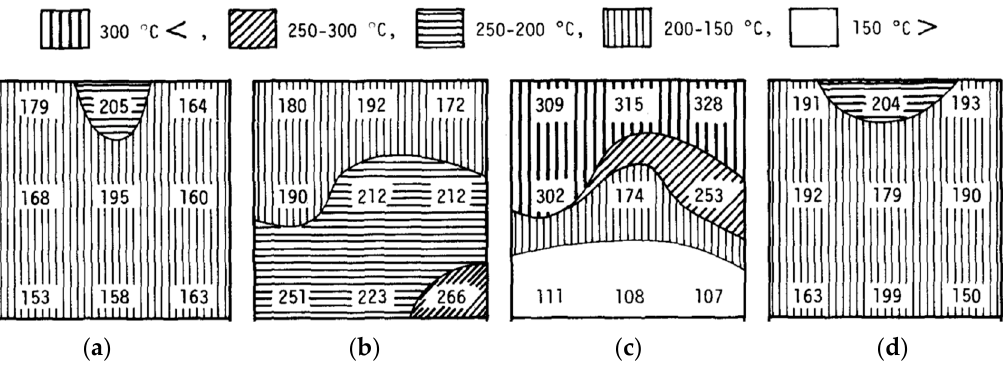
Figure 7. Distribution of spot temperature over catalyst surface for a Pt/ceramic honeycomb ( a ), Pd/Ni foam (11– 15 cells/inch) ( b ), Pd/Ni foam (35–44 cells/inch) ( c ), and Co–Mn–Ag oxide/ceramic foam ( d ) (reproduced from [143] with permission from